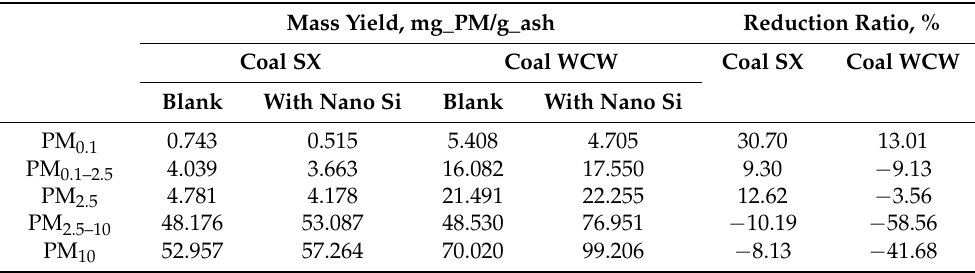
Table 3. Mass yields of PM 0.1 , PM 0.1–2.5 , PM 2.5 , PM 2.5–10 and PM 10 and their reduction ratio after adding nano SiO 2 into coals SX and